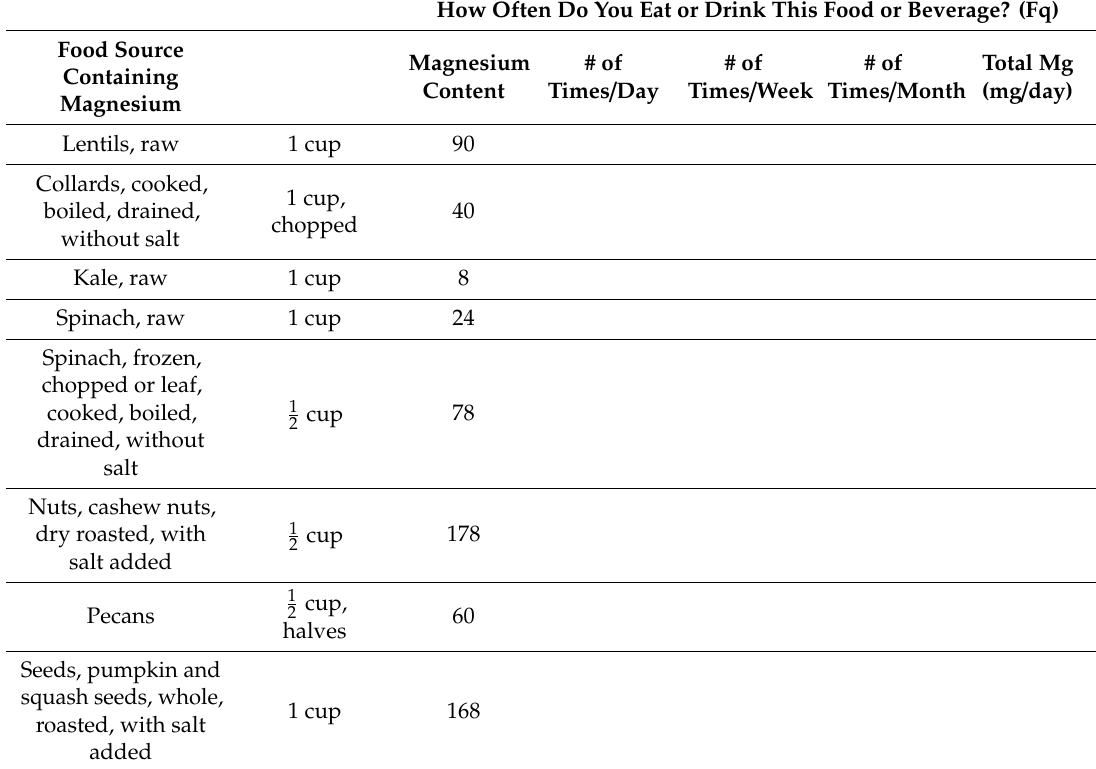
Table A1. Magnesium Food Frequency